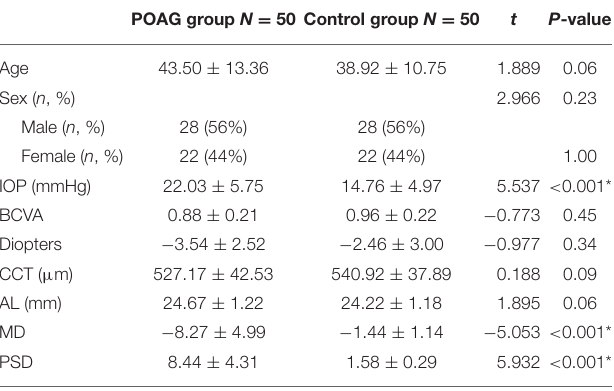
TABLE 3 | Correlations between RV diameters and VFS or RNFLT within the parapapillary region and individual temporal sectors. Parapapillary Temporal Temporal Temporal superior